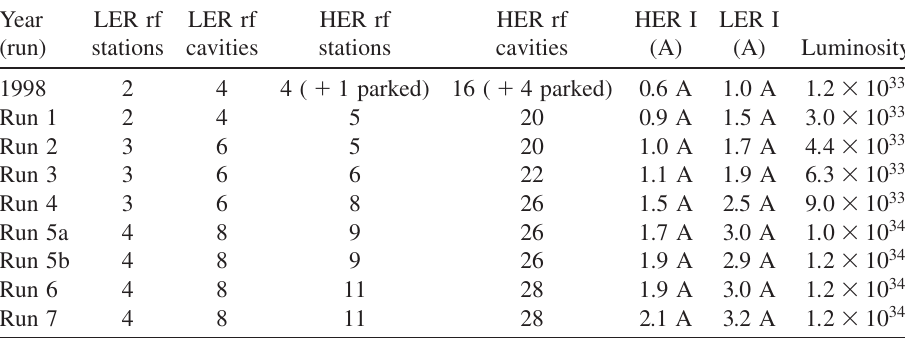
TABLE I. Summary of rf configurations used in PEP-II from initial commissioning through the end of operations in April 2008. The design luminosity and current goals were achieved in run 1. At the cessation of operations the machine was operating with currents at 1.8X design LER, 2X design HER, and with 4X design luminosity. During this interval the HER reconfigured the rf stations such that a 4-cavity station was reconfigured as a 2-cavity station, and subsequent HER station additions were 2-cavity stations. Over this course of operations the rf configurations were in continuous development following varying installed complements of rf stations, rf